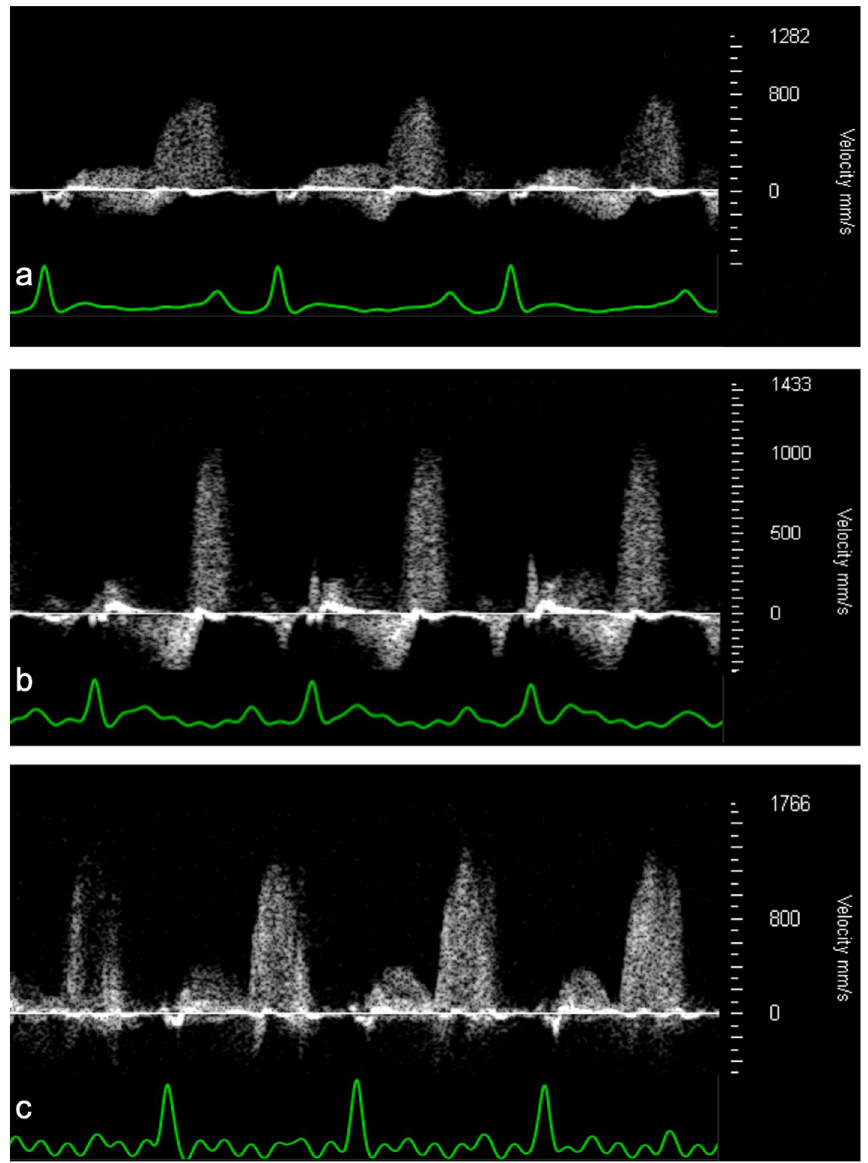
Fig. 3 Representative pulsed-wave Doppler coronary flow patterns. The signals are shown with the corresponding electrodardiographic signal during baseline conditions ( a ), infusion of 140 μg/kg body weight/min adenosine ( b ), and infusion of 10 μg/kg body weight/min dobutamine ( c